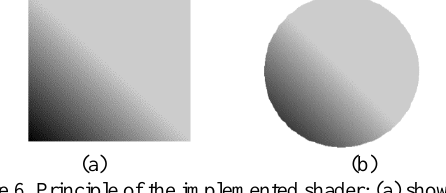
Figure 6. Principle of the implemented shader: (a) shown with the square shape, (b) and a circle.